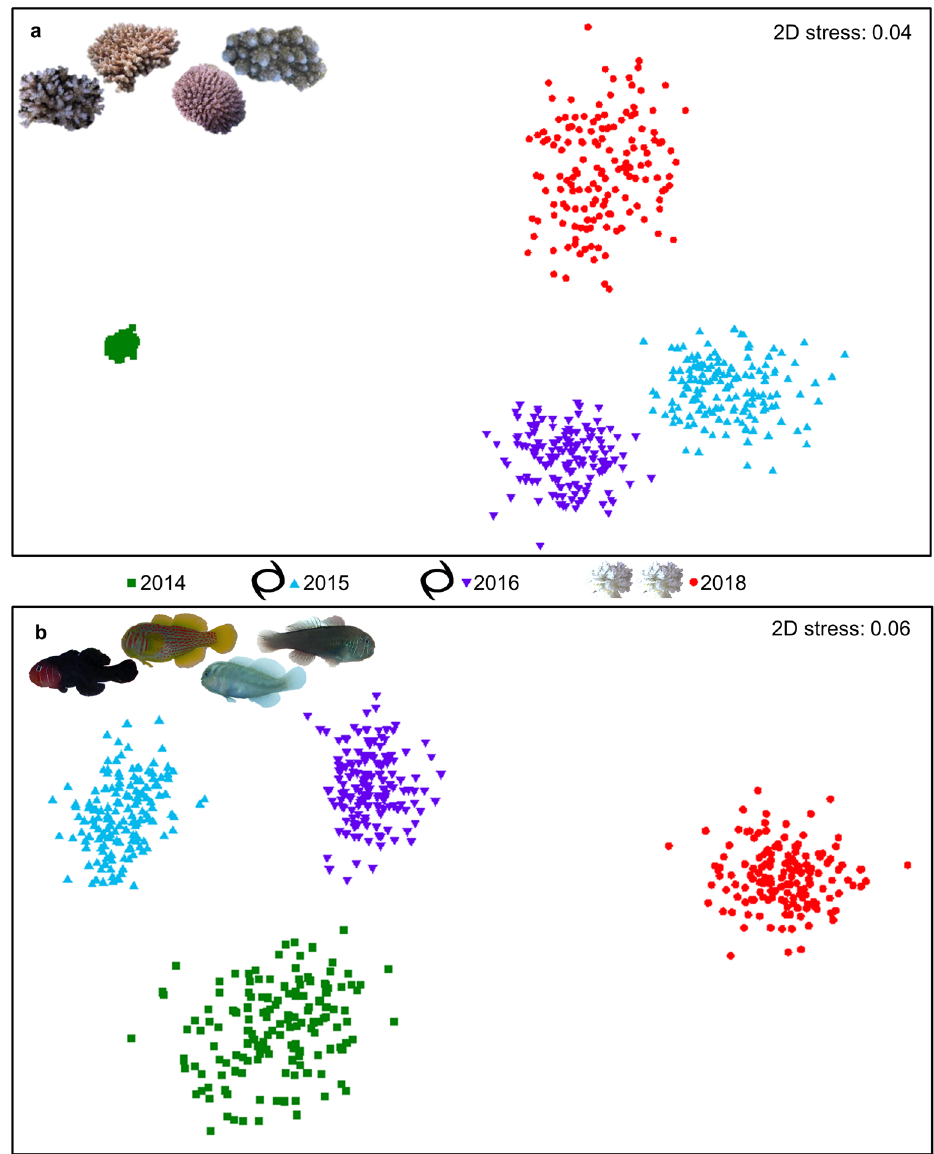
Figure 3. Shifts in communities of corals and gobies throughout consecutive climate disturbances. The changes in communities along transects (n = 279) before and after each cyclone (black cyclone symbols) and after two consecutive heatwaves/bleaching events (white coral symbols) at Lizard Island, Great Barrier Reef, Australia, for ( a ) Acropora corals and ( b ) Gobiodon gobies visualized on non-metric multidimensional scaling plots. Each colored point represents a single transect, points represent bootstrapped data, and points closer together are more similar in species composition than points further apart. Figures were illustrated in PRIMER-E software (v7, https:// www. primer- e. com/) and Microsoft Office PowerPoint